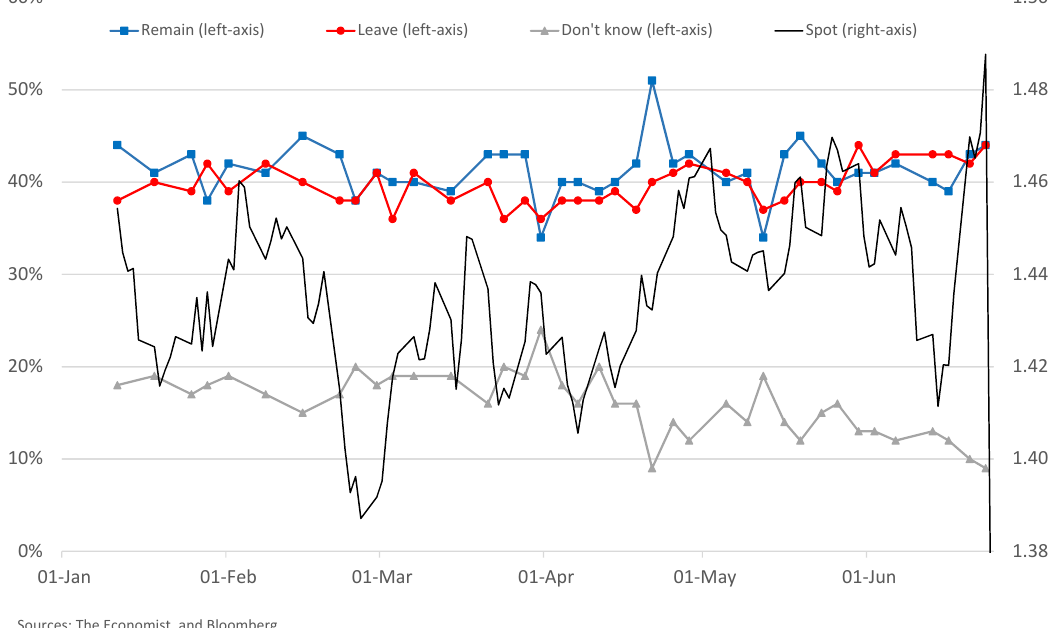
Figure 1. Brexit poll results vs. GBPUSD FX spot rates (11 January to 23 June